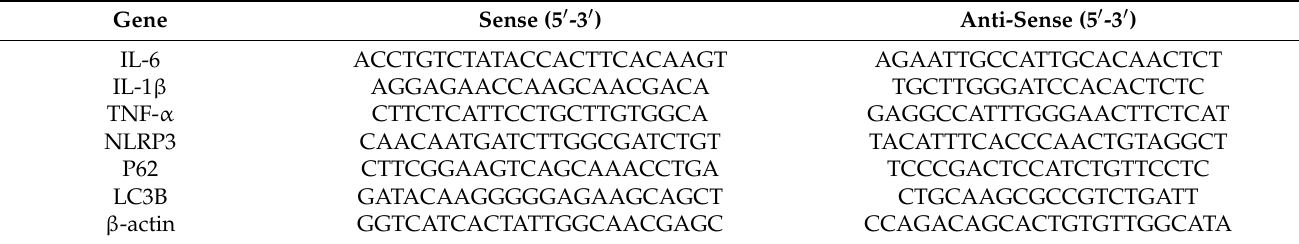
Table 1. Primer sequences of IL-6, IL-1 β , TNF- α , NLRP3, P62, LC3B and β